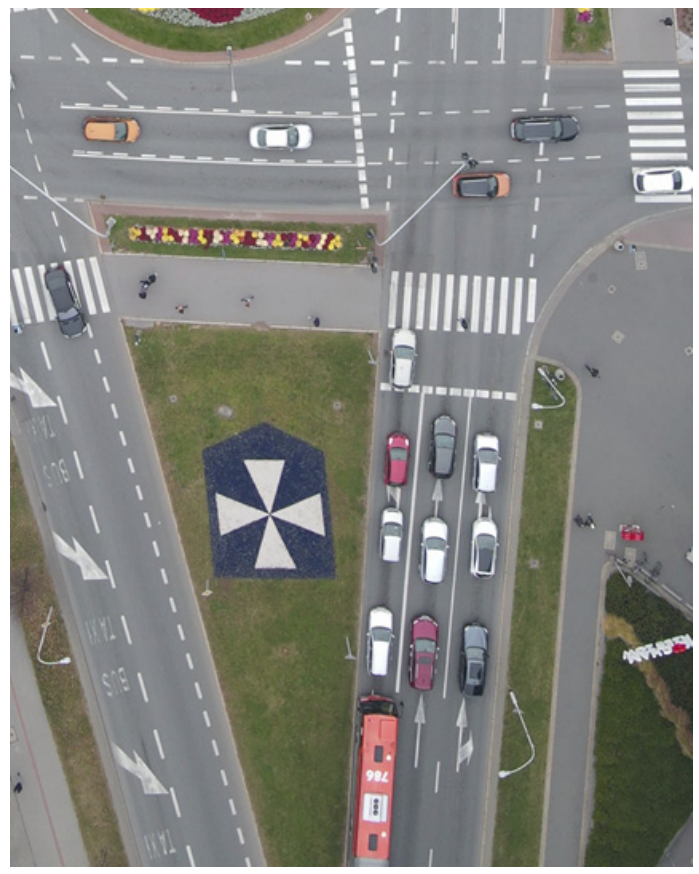
Figure 5. Collecting traffic data using a drone observation at an intersection in Rzeszów.